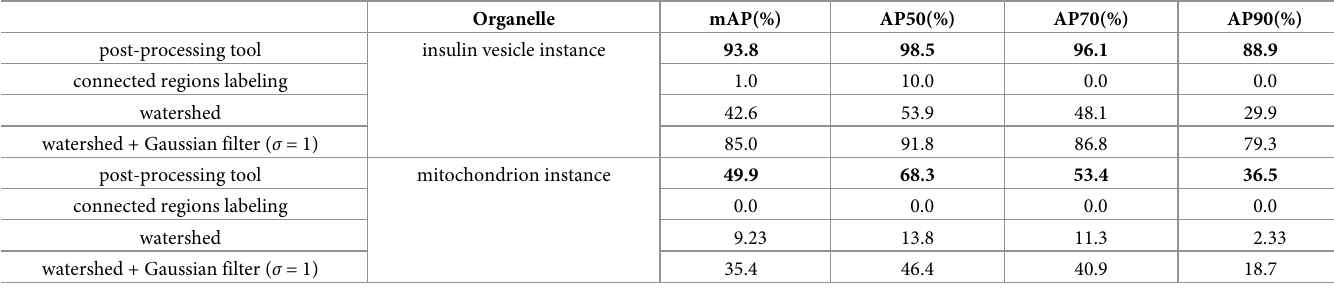
Table 1. Instance mask AP on test datasets.